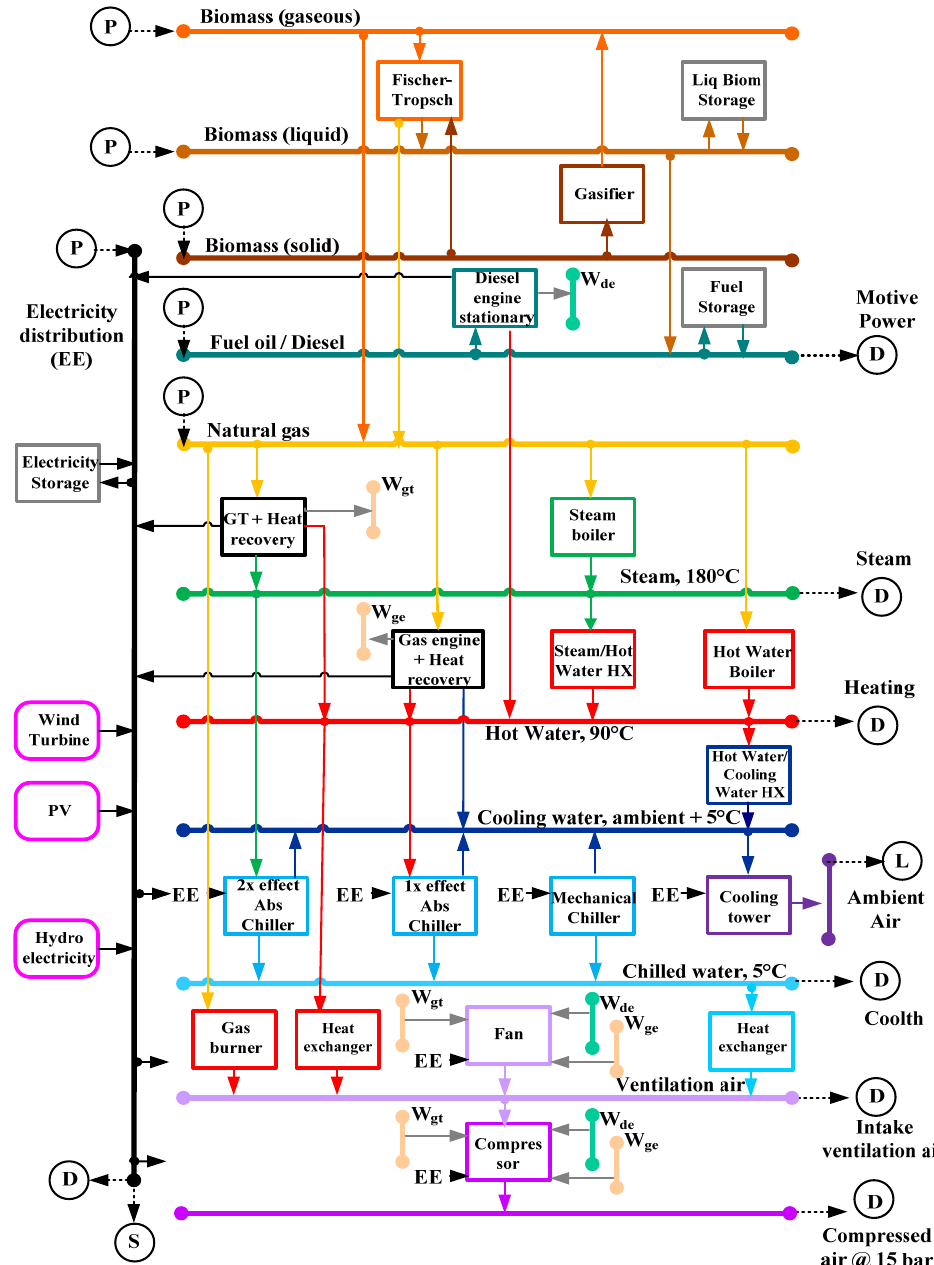
Figure 6. Superstructure of an energy supply system for a